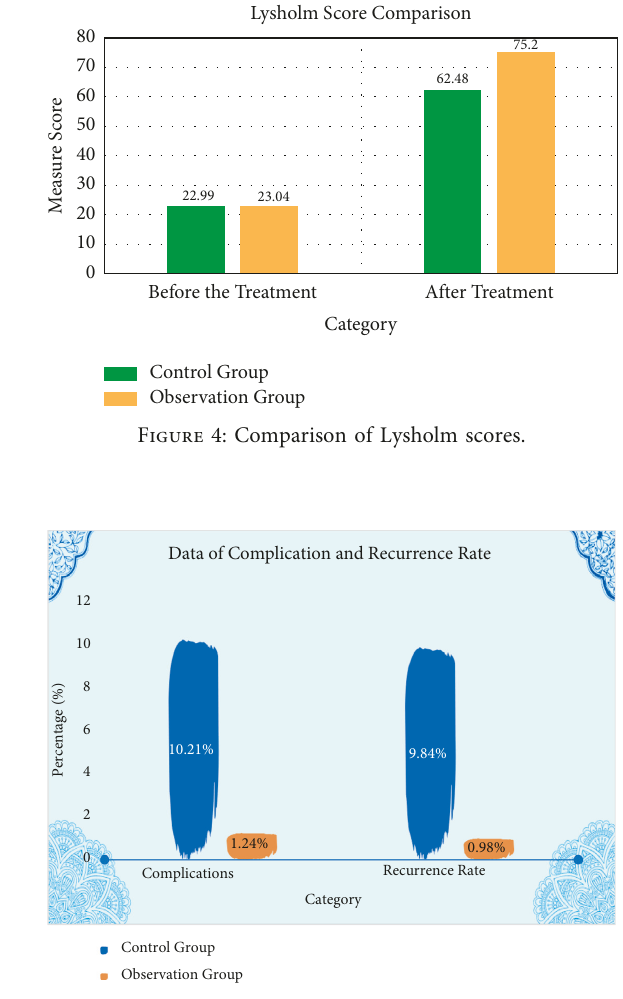
Figure 5: Comparison of complications and recurrence rates between the two